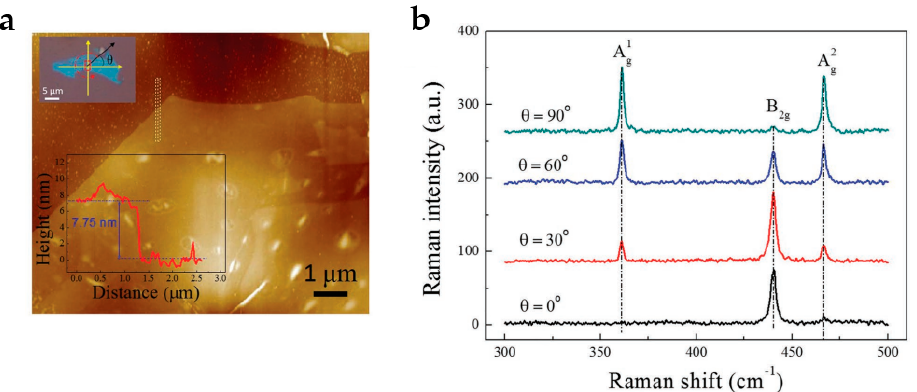
Figure 14. The optical properties of BP. ( a ) An AFM image of a thin BP flake reveals an approximate thickness of 7.75 nm. Inset: a photograph of this BP flake. ( b ) Raman spectrum of BP utilizing polarized laser stimulation in various orientations. (Reprinted with permission from ref. [173] .